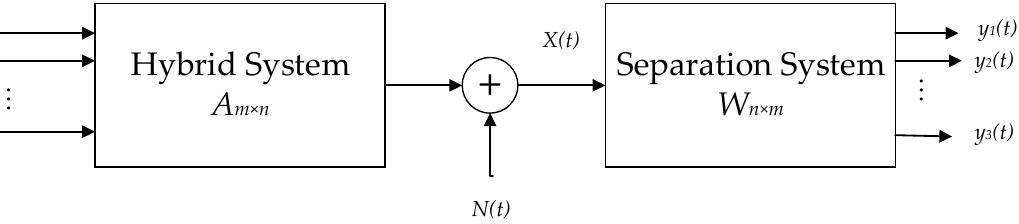
Figure 1. Linear mixed blind source separation model.